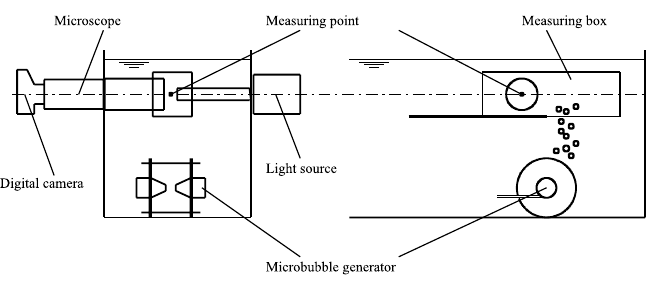
Fig. 2 Photographic technique.